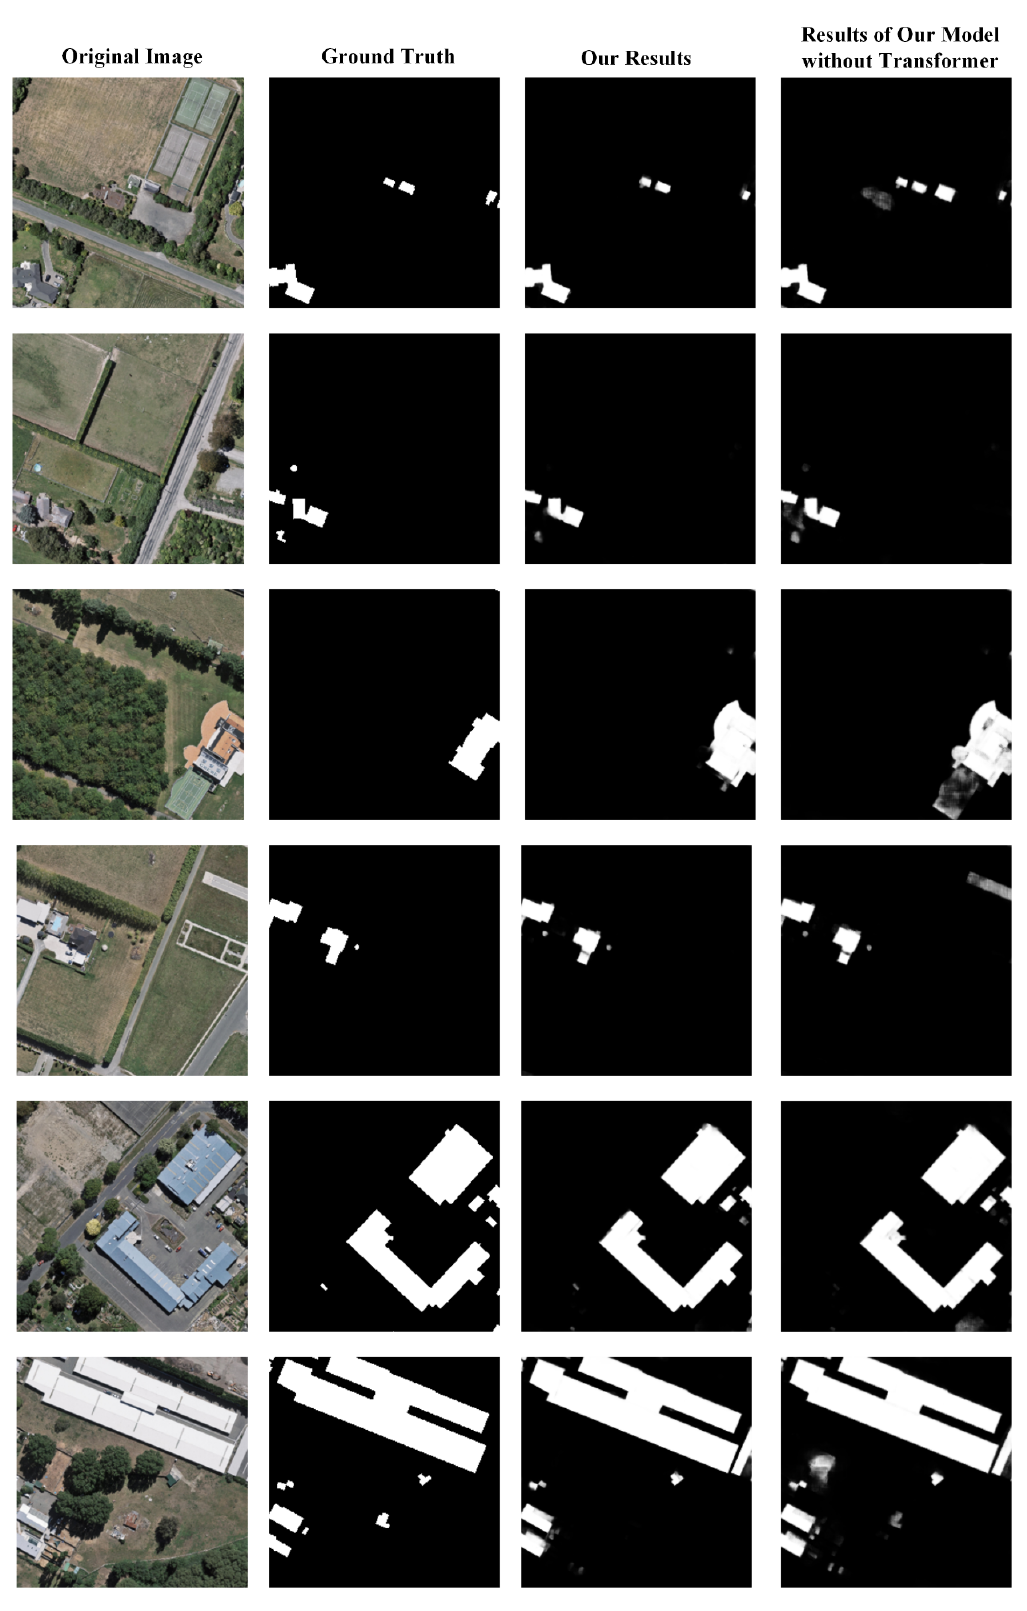
Figure 8. Several sample result comparisons in visual between our model with and without the transformer module. The first, second, third and fourth columns represent the original images, ground truths, results with transformer and results without transformer, respectively.